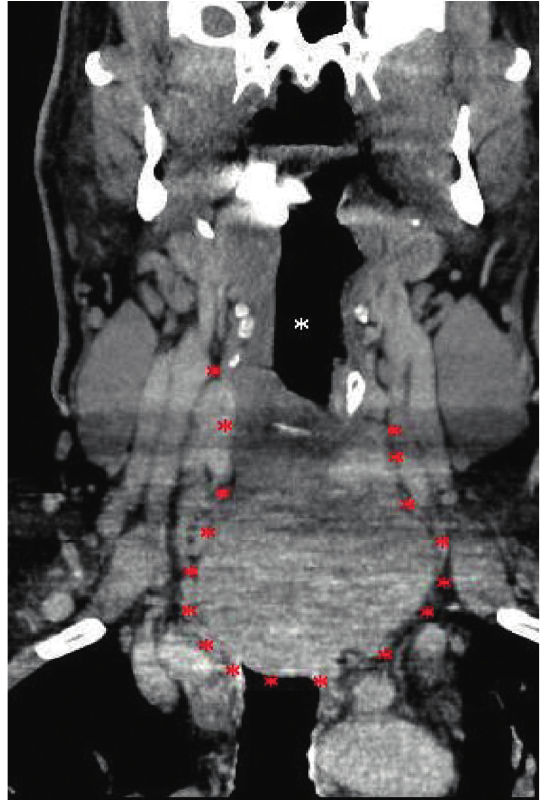
Figure 2: Enhanced coronal computed tomography image dem- onstrating a large thyroid mass (red asterisk) with invasion of the superior mediastinum. The airway (white asterisk) is displaced outside the field of view of this